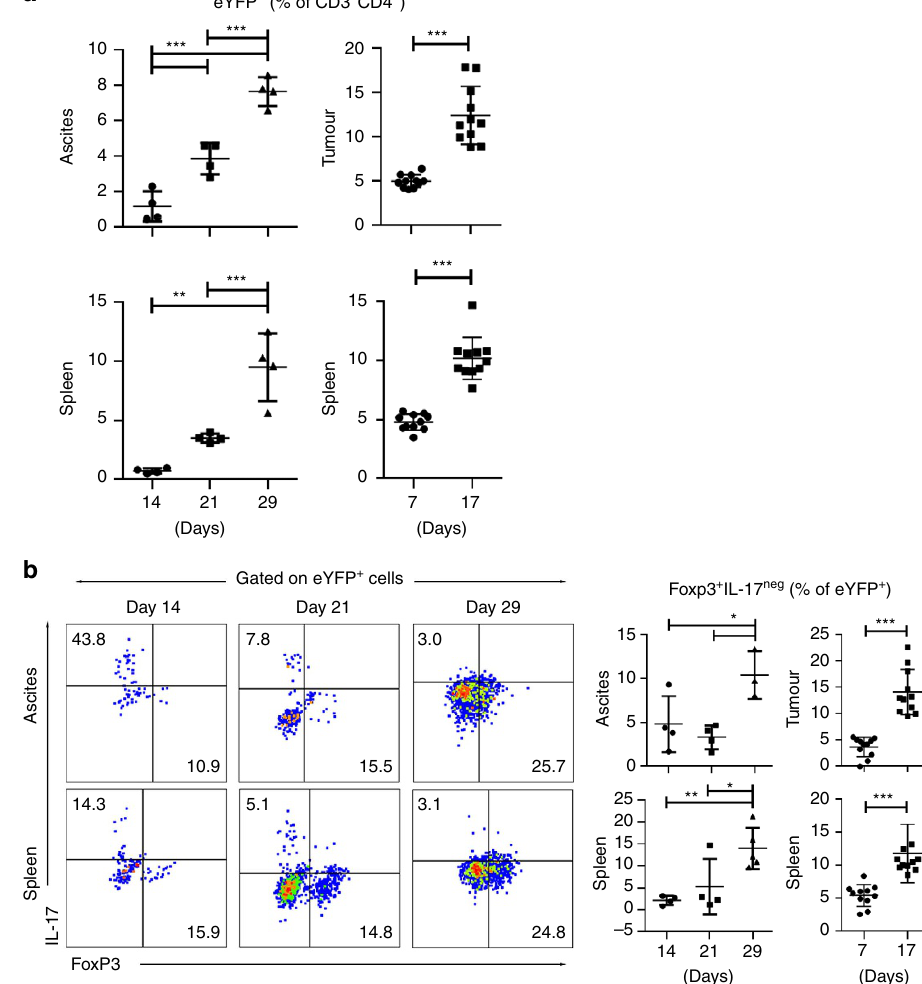
Figure 1 | Th17 cells transdifferentiate into Foxp3 þ exTh17 cells in tumour-bearing mice. ID8A ovarian cancer and MC38 colorectal cancer cells were injected intraperitoneally in IL-17a Cre R26R ReYFP fate reporter mice. TALs (ovarian cancer, n ¼ 4 mice per group), TILs (colorectal cancer, n ¼ 10 mice per group) and splenocytes were recovered at different time points of tumour progression and CD4 þ T cells assessed for eYFP expression ( a ) as well as eYFP þ cells analysed for IL-17 production and Foxp3 expression ( b ) by flow cytometry. The fluorescence-activated cell sorting (FACS) gating strategy of live eYFP þ CD4 þ Tcells is presented in Supplementary Fig. 8a. We observed accumulation of eYFP þ cells (indicative of Th17 and/or exTh17 cells) over time ( a ) and the percentages of Foxp3 þ IL-17A (cid:2) (that is, exTh17 T reg ) cells increased in these mice with tumour progression. All data are mean ± s.d. * P o 0.05, ** P o 0.01 and *** P o 0.001 by two-tailed Student’s t -test. Similar results were obtained in an additional